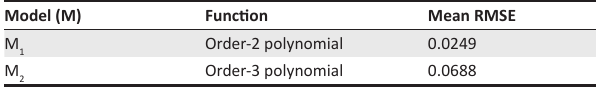
FIGURE 5: The variation of the loss rate for M TABLE 4: The root-mean-squared error result for the each model. Model (M)